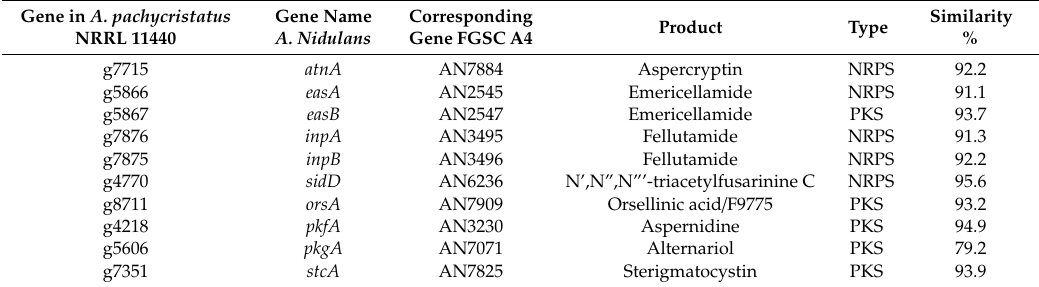
Table 3. Core biosynthetic genes from inferred biosynthetic clusters for metabolites identified in Aspergillus pachycristatus and their homologs in A.